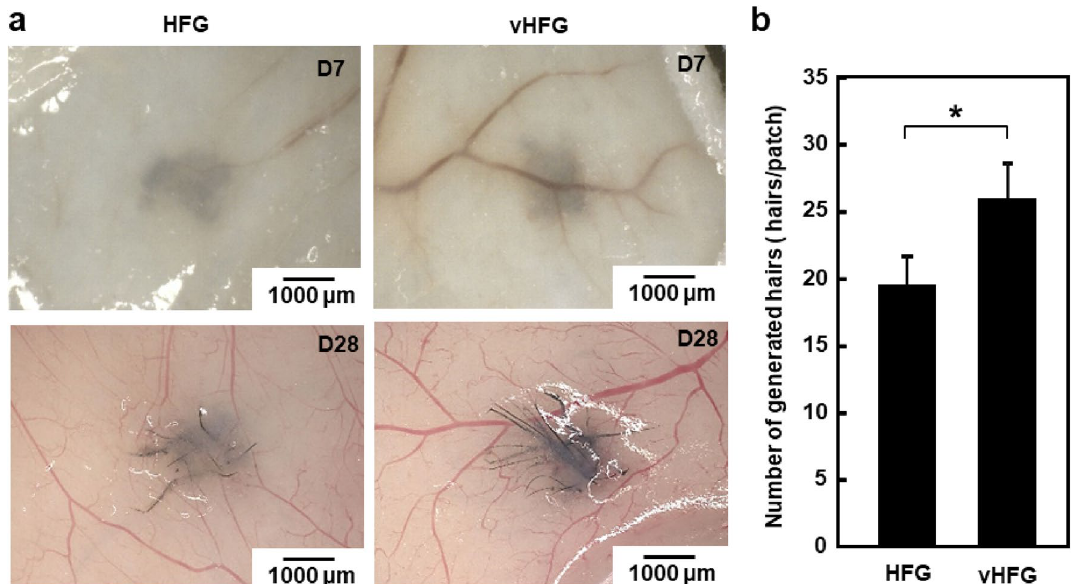
Figure 4. Hair-patch assay with vHFGs. ( a ) Hair shafts generated from 30 vHFGs and 30 HFGs in the lateral dorsal skin. ( b ) Quantification of generated hair shafts. The values and error bars represent at least four experiments for each condition. * p < 0.05 was considered significant. The values and error bars were calculated based on at least five